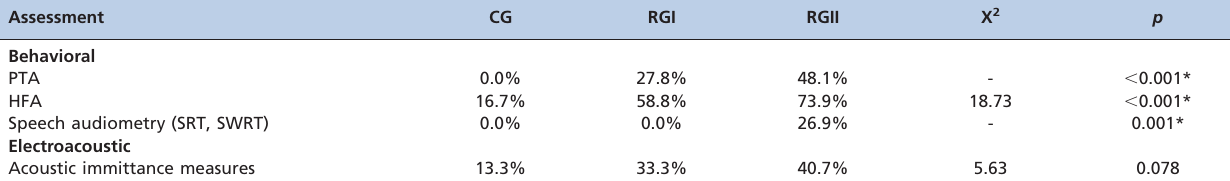
Table 4 - Comparisons of proportions of alterations in the behavioral and electroacoustic assessments of hearing between the Control Group, Research Group I and Research Group II (Chi-squared test or Fisher’s exact test). Assessment